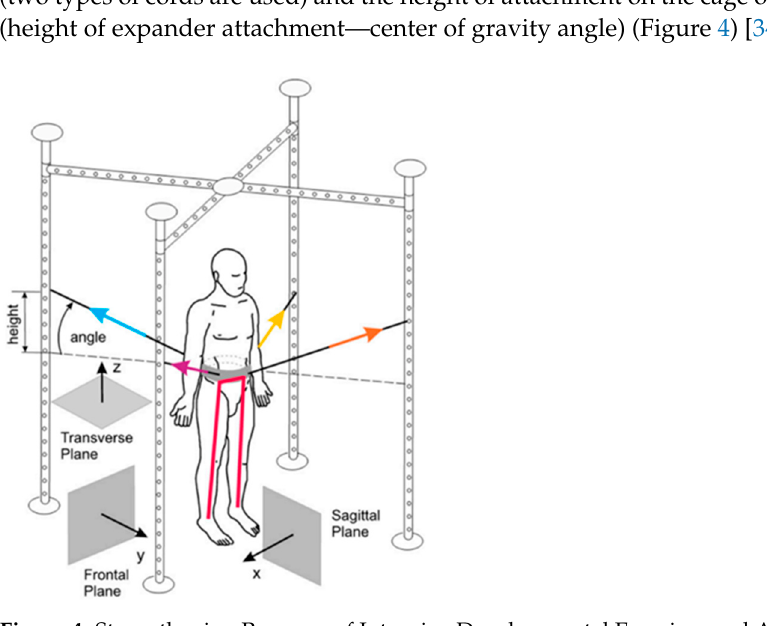
Figure 4. Strengthening Program of Intensive Developmental Exercises and Activities for Reaching Maximal Potential (SPIDER) equipment (SPIDER net) with the reference planes and the expander forces in the standard anatomical position [36].